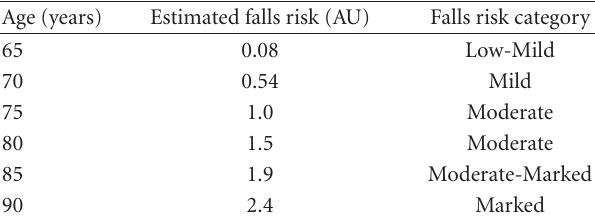
Table 4: Estimates of age-related falls risk (based on age and physical